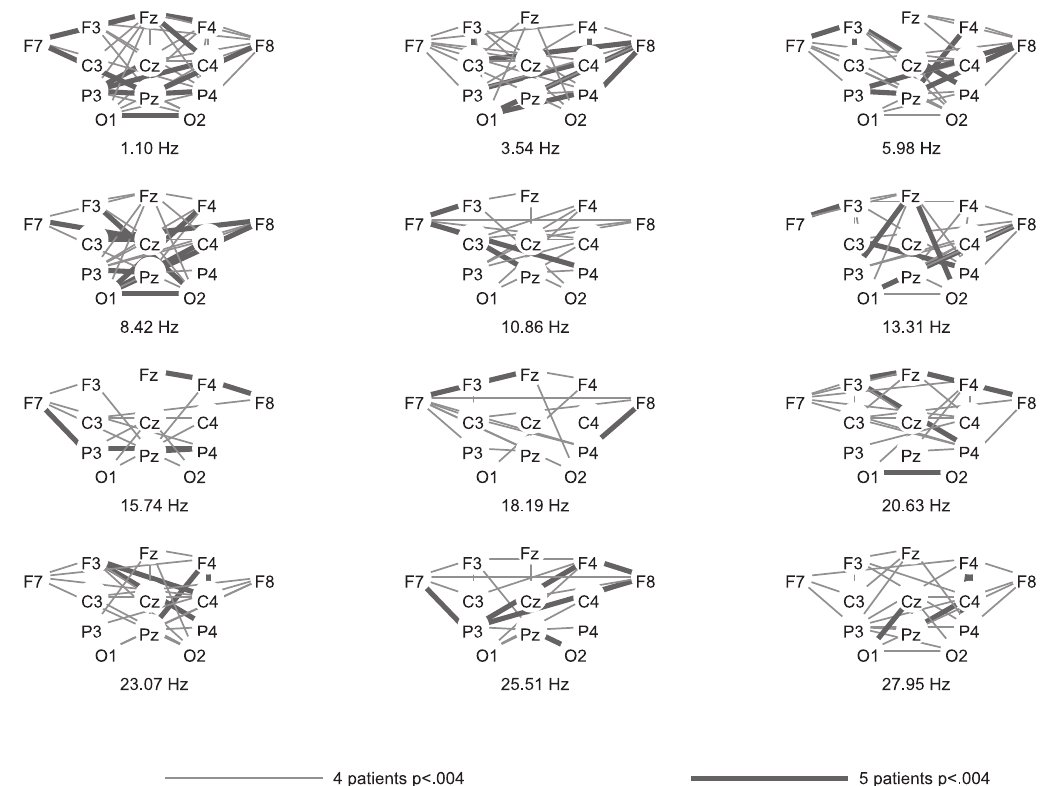
Figure 6. Numbers of patients in MCS with significant (FDR-corrected) coherences.